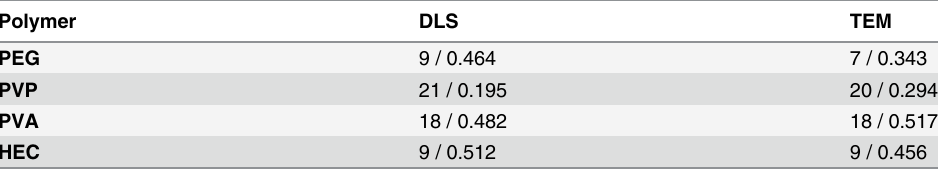
Table 2. Average diameter (nm) / polydispersity of Ag NPs prepared by the reduction of AgBr NPs by the NaBH 4 in the presence of various polymers obtained by DLS and TEM